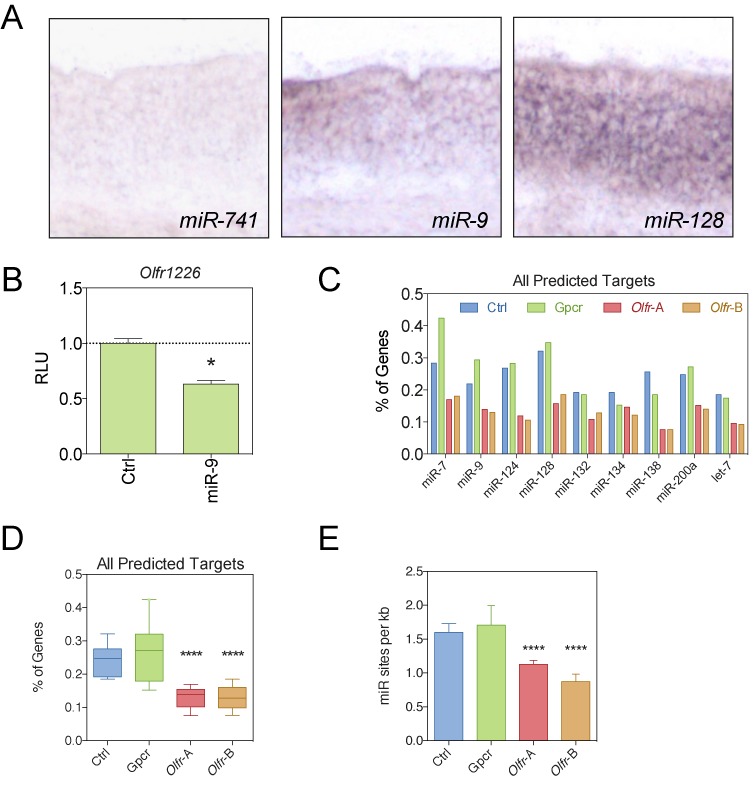
Olfr mRNAs tend to have few predicted target sites for neurally expressed miRNAs. (A) In situ hybridization of neurally expressed miRNAs in the OE. (B) Dual luciferase analysis of the effect of the Olfr1226 3′ UTR in response to ectopic expression of miR-9 in Neuro2A cells. (C) The percentage of mRNAs from the indicated gene groups with predicted miRNA-binding site defined using the TargetScan algorithm. (D) Boxplot representation of the average percentage of miRNA-binding sites determined across all 9 miRNAs, determined from the data in panel C. (E) Average frequency of miRNA sites per kb of 3′UTR in each gene group. *P < 0.05; ****P < 0.0001.